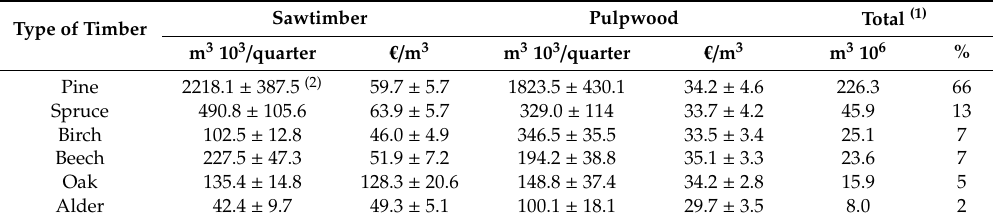
Table 1. Summary of data used for empirical estimation: